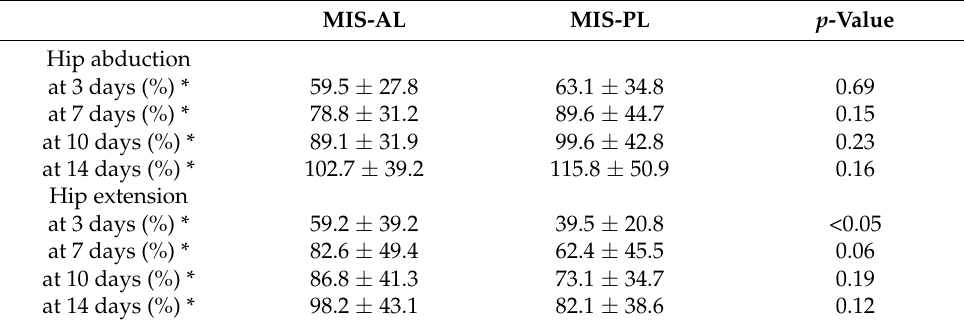
Table 5. Comparison of pre- versus postoperative recovery rates of muscle strength. MIS-AL MIS-PL p